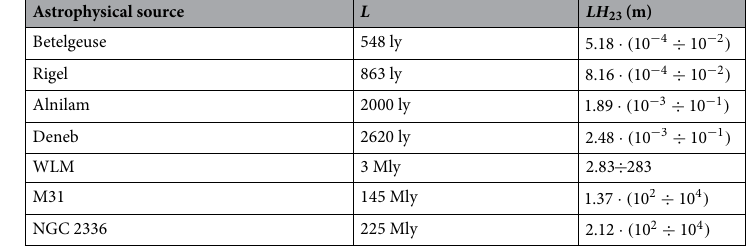
Table 1. Numerical values of the quantity LH 23 for a massless particle in the case of an elliptically polarized gravitational wave and for different astrophysical bright objects. The two numbers appearing in the column for LH 23 refer to choices of a strain h with magnitude 10 − taken from 33–36 . We recall that one megalight-year (Mly) is 10